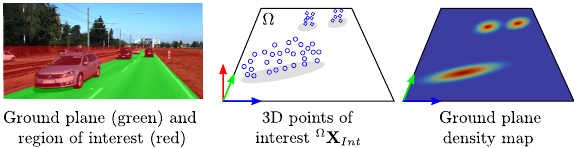
Figure 2. Scheme of the generic object